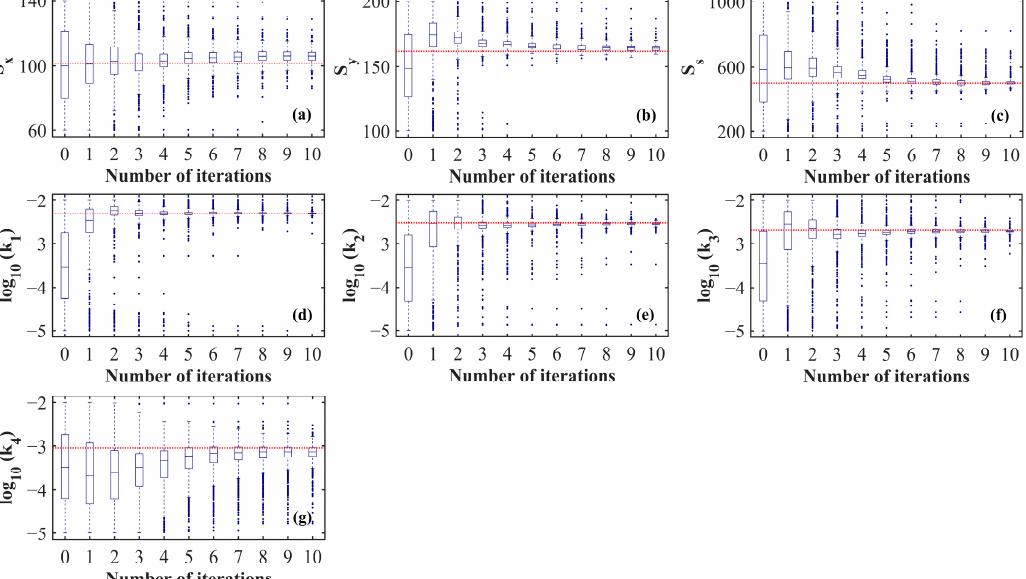
Figure 13. Box plots of model parameters estimated by ILUES in Case 3: ( a , b ) source location ((cid:1845) (cid:3051) ,(cid:1845) (cid:3052) ) , ( c ) source strength ((cid:1845) (cid:3046) ) , ( d – g ) the four rate constants ((cid:1863) (cid:2869) ,(cid:1863) (cid:2870) ,(cid:1863) (cid:2871) ,(cid:1863) (cid:2872) ) . The red dashed lines denote the true values of corresponding model parameters. To further verify the advantage of ILUES, the RMSE between the reference true values and the estimated values of selected model parameters is introduced to evaluate the estimation accuracy. The RMSE of selected model parameters estimated by ILUES and ES-MDA are listed in Table 7. As clearly shown in Table 7, the RMSE values of estimated model parameters with the implementation of ILUES are all lower than those using ES-MDA. As lower RMSE values indicate